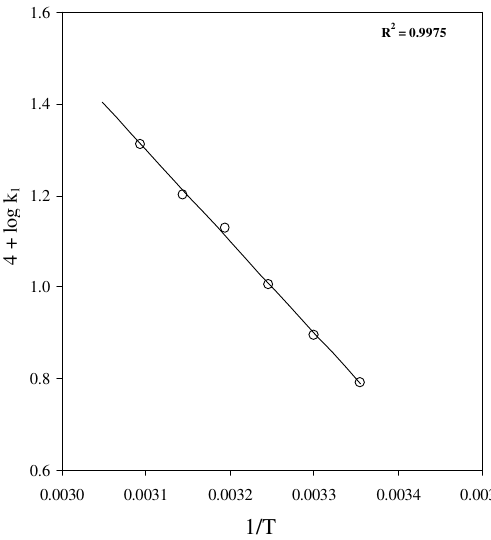
Figure 6. Variation of rate with temperature (Lactic